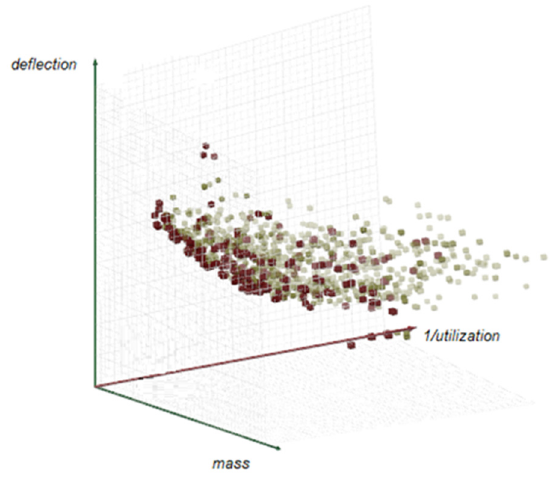
Figure 7. 3D Pareto front received during optimization. Table 1. The simulation results for the hyperbolic paraboloid structure with a grid pattern of type a (the grid split along shorter diagonals).